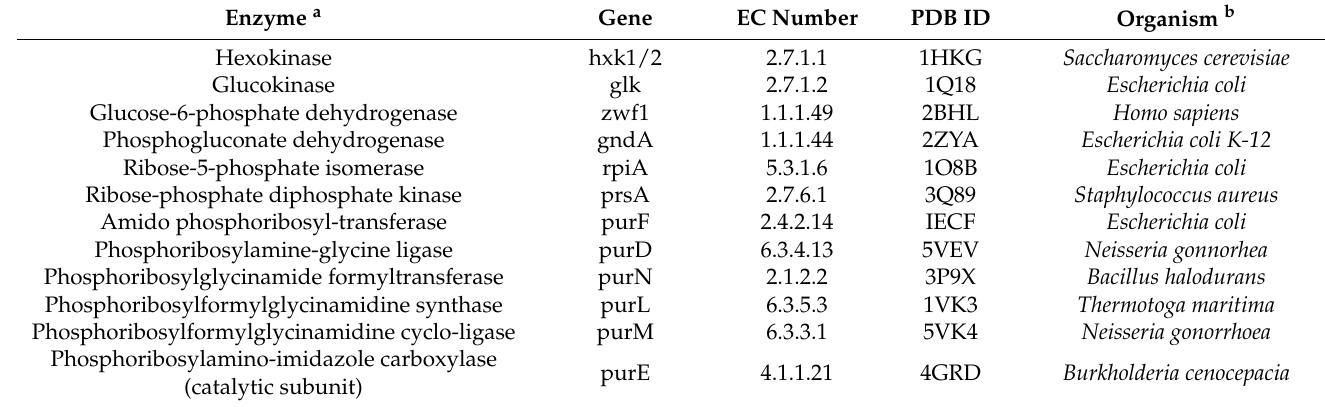
Table 2. Enzymes of the purine de novo biosynthetic